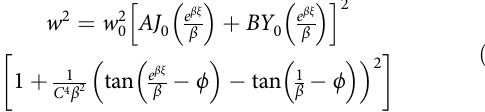
optical electric fi eld envelope: E r ; z ð